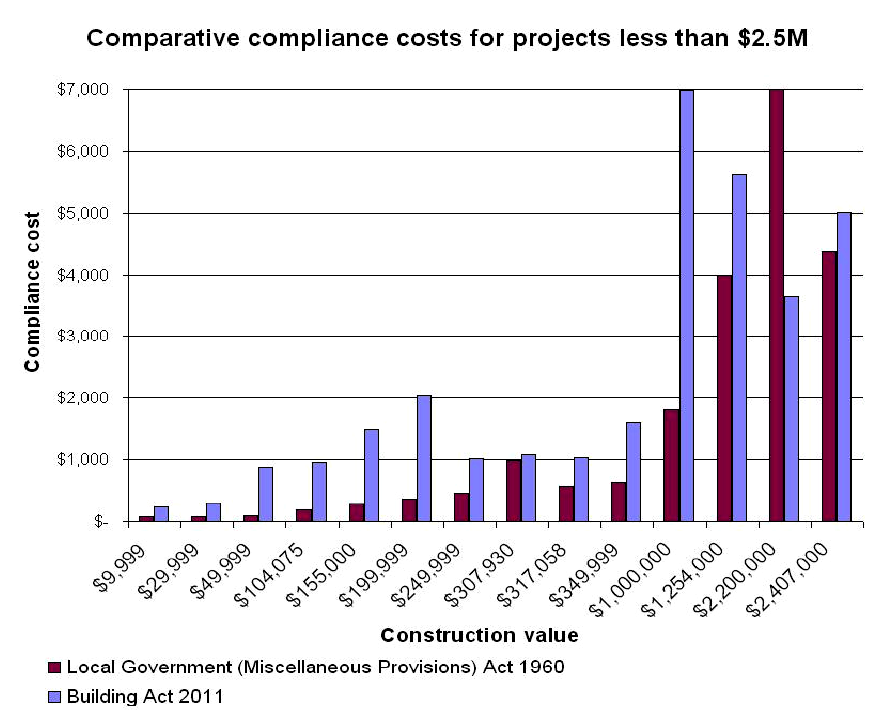
Figure 1 Comparative compliance costs under the Local Government (Miscellaneous Provisions) Act 1960 and the Building Act 2011, for 14 projects with construction values less than $2.5 million.